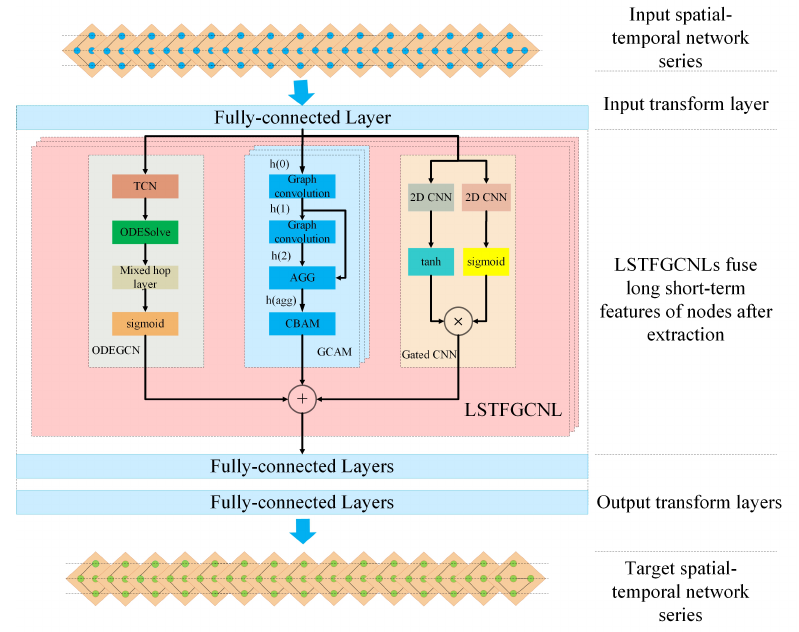
Figure 2. General framework of